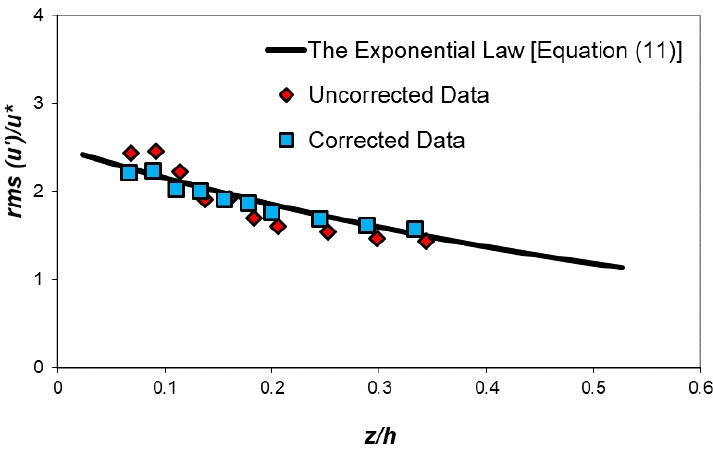
Figure 6. Normalised turbulent intensity over the laboratory-prepared well-packed rough bed.